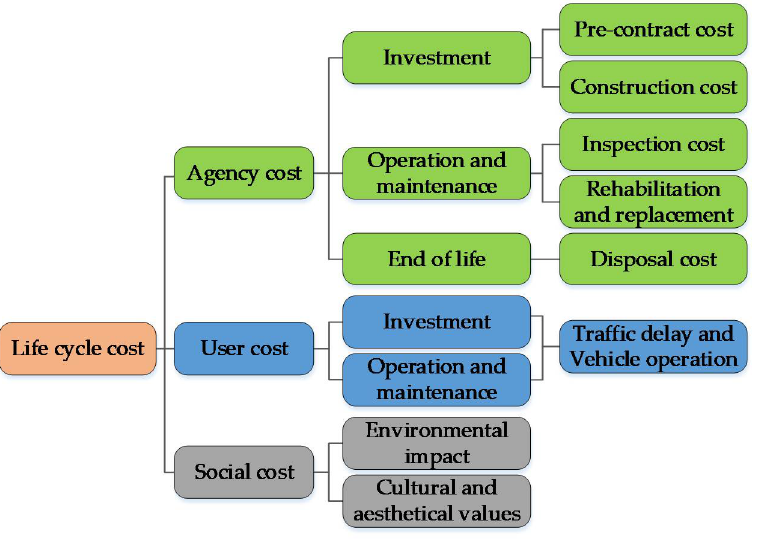
Figure 12. Cost categories in LCC